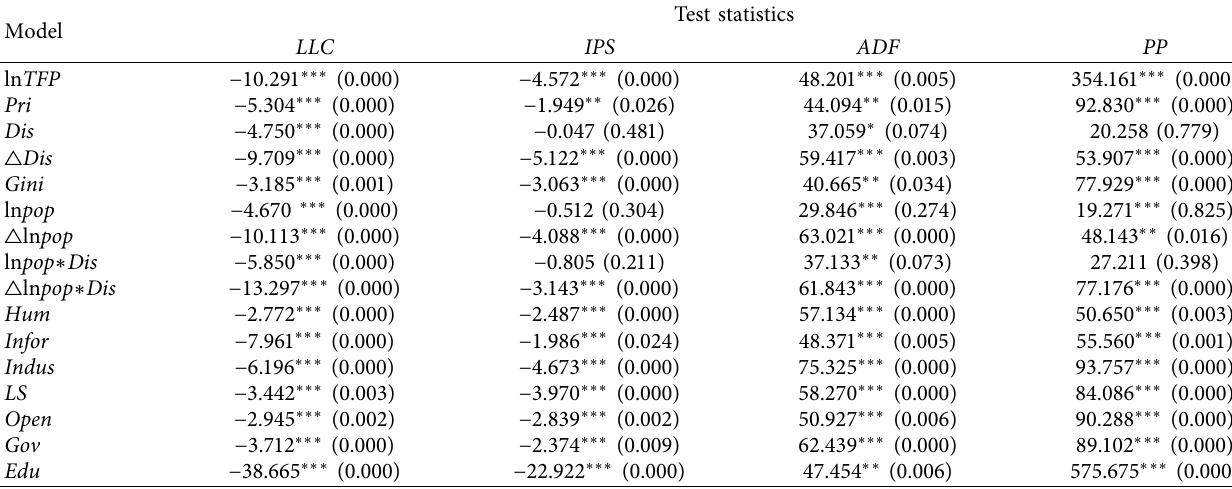
Table 7: Test results of unit root.